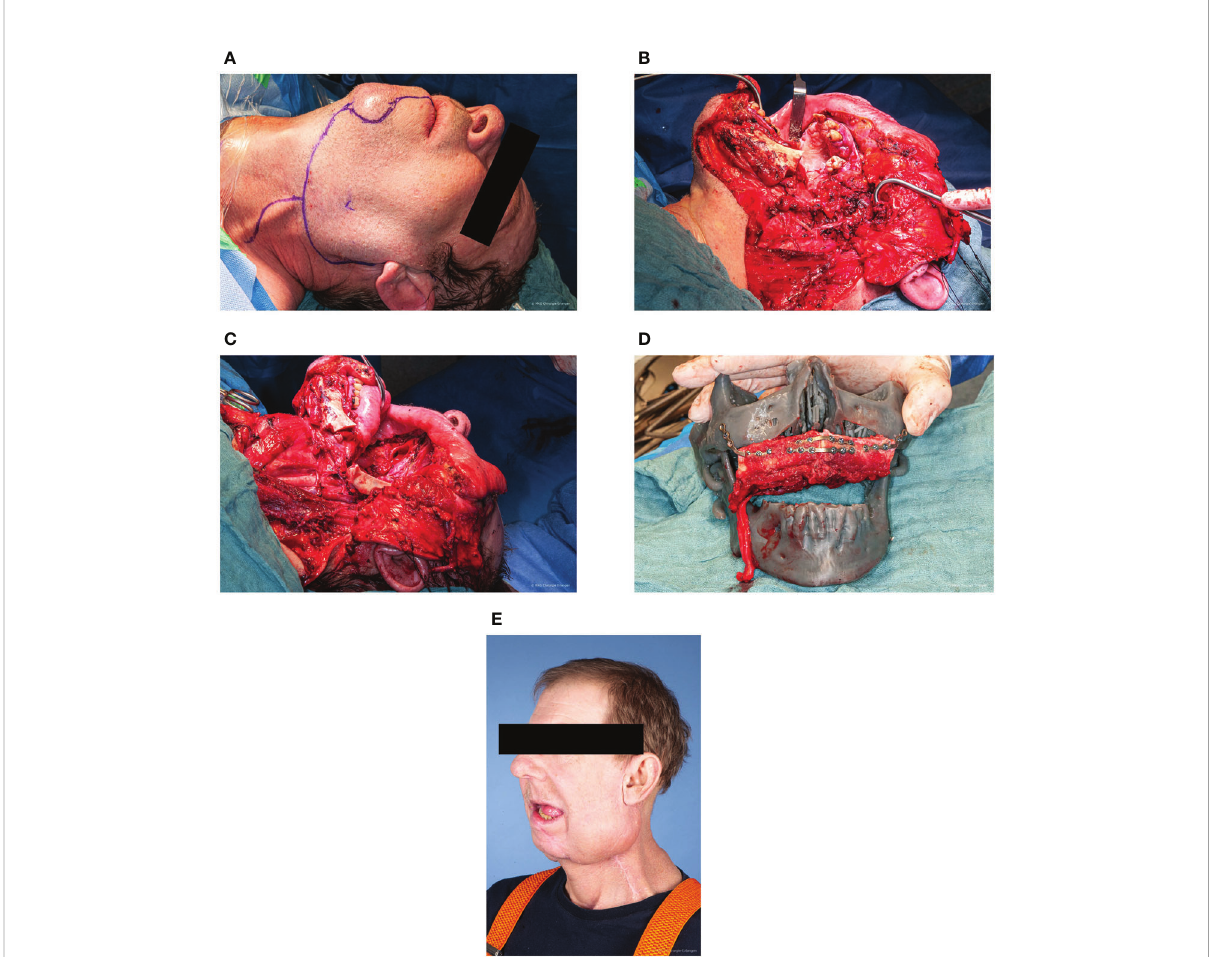
FIGURE 1 Case A (A) Preoperative sketching of the surgical incision. Photo taken under intubation anaesthesia. Preauricular and submandibular approach with temporary lip-split mandibulotomy. (B) Intraoperative view of the tumor on the left maxilla. Situs after successful access via preauricular and submandibular with temporary lip-split mandibulotomy with view of the tumor in the maxilla. (C) Intraoperative view after bilateral neck dissection and radical tumor resection. Neck dissection level I-V left and I-III right with vascular presentation on both sides. Radical tumor resection by way of bilateral maxillectomy. (D) CAD-CAM assisted microvascular double fl ap reconstruction. In domo planned and printed surgical model for sagittal positioning of the microvascular 2-segment fi bula transplant. An additional microvascular latissimus dorsi graft was used for enoral soft tissue reconstruction. (E) Last follow-up in early-April 2022 - 5 months postoperative. No signs of tumor recurrence. Functionally satisfying rehabilitation with good mouth